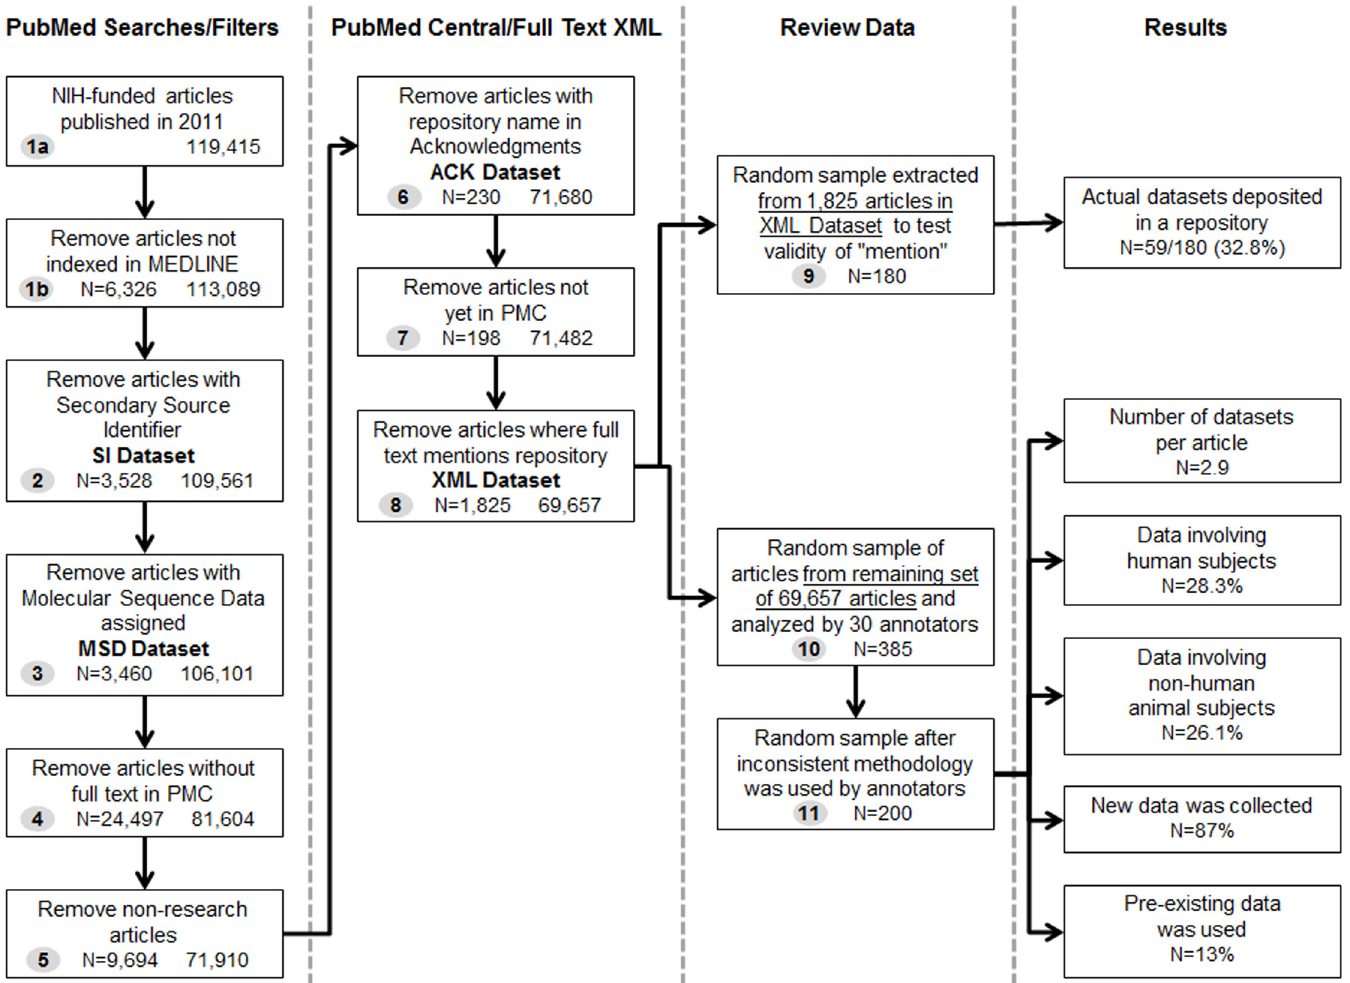
Fig 1. Diagram of process taken to identify NIH-funded datasets via the published journal literature (Including Results).